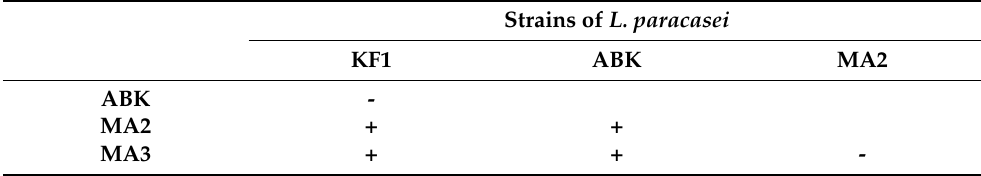
Table 1. The antagonistic interactions between the studied strains of L. paracasei . Strains of L. paracasei